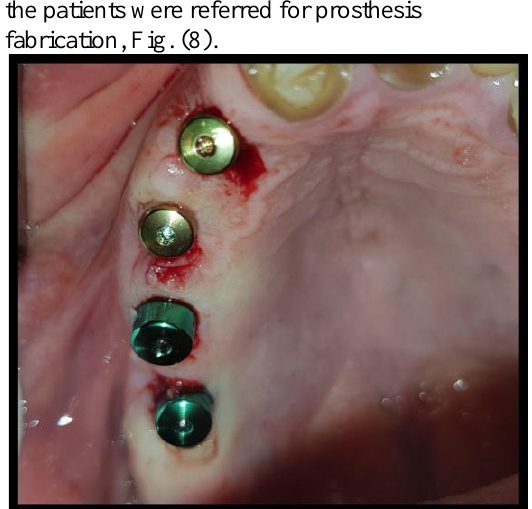
Figure 7: Healing abutment connection after six months.